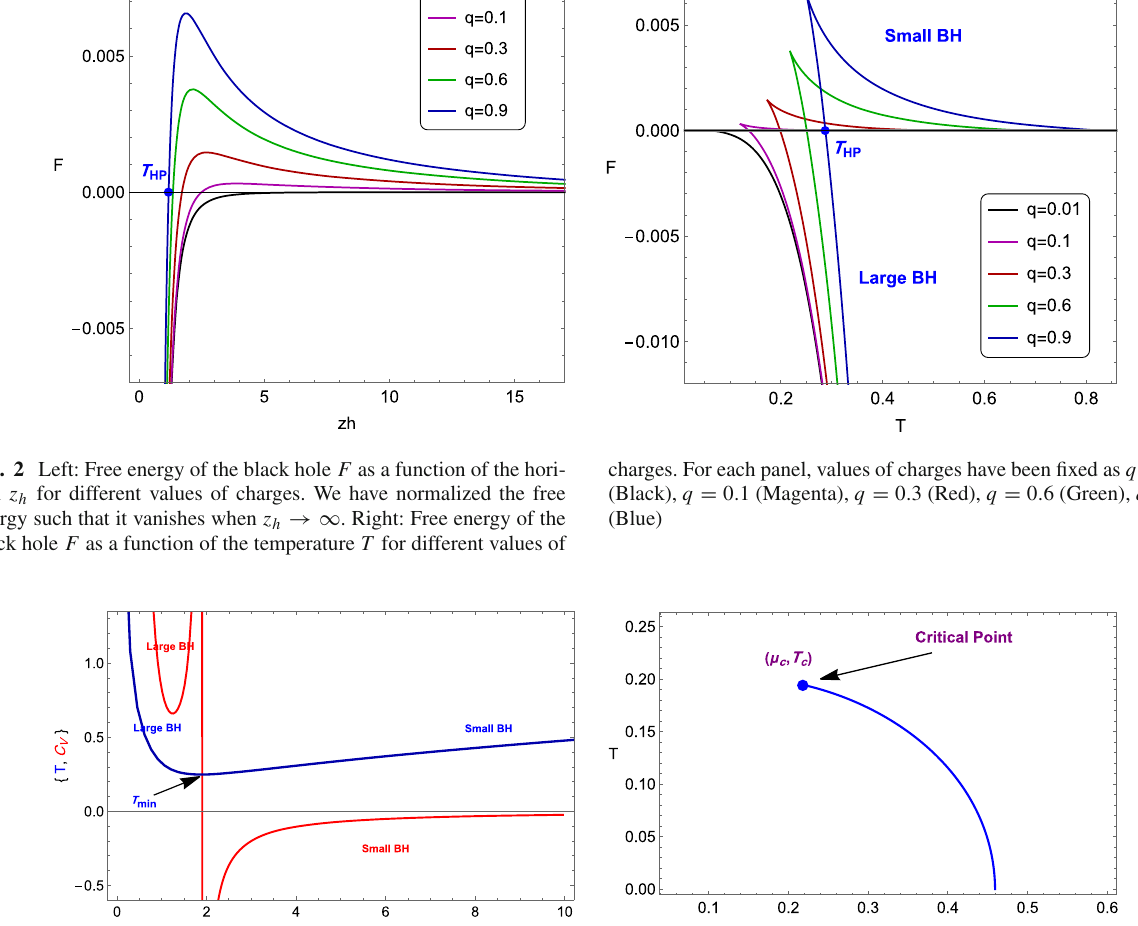
the black hole T as a function of the chemical potential μ . The critical point (μ c , T c ) is shown in this panel such that we have μ c